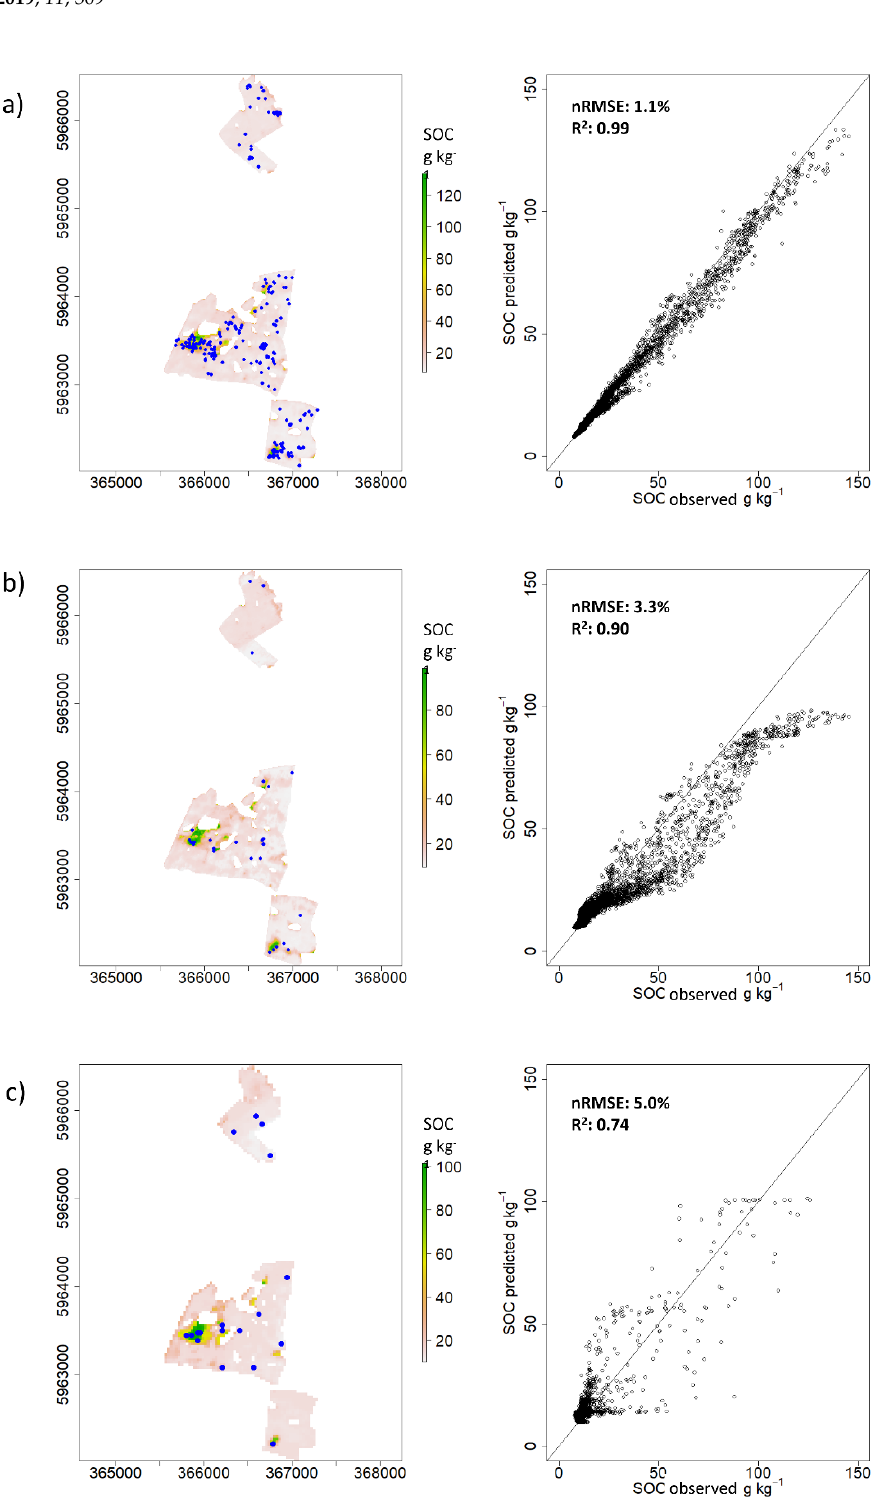
Figure 7. The outputs obtained applying the Puchwein ( a ) and the Puchwein+SELECT ( b ) algorithm using the Sentinel-2 data, and those obtained using the Puchwein algorithm with EnMAP data ( c ). The location of the soil samples collected for the calibration datasetin the lefthand panels and the plot of observed against predicted SOC content for each pixel in the righthand panels.